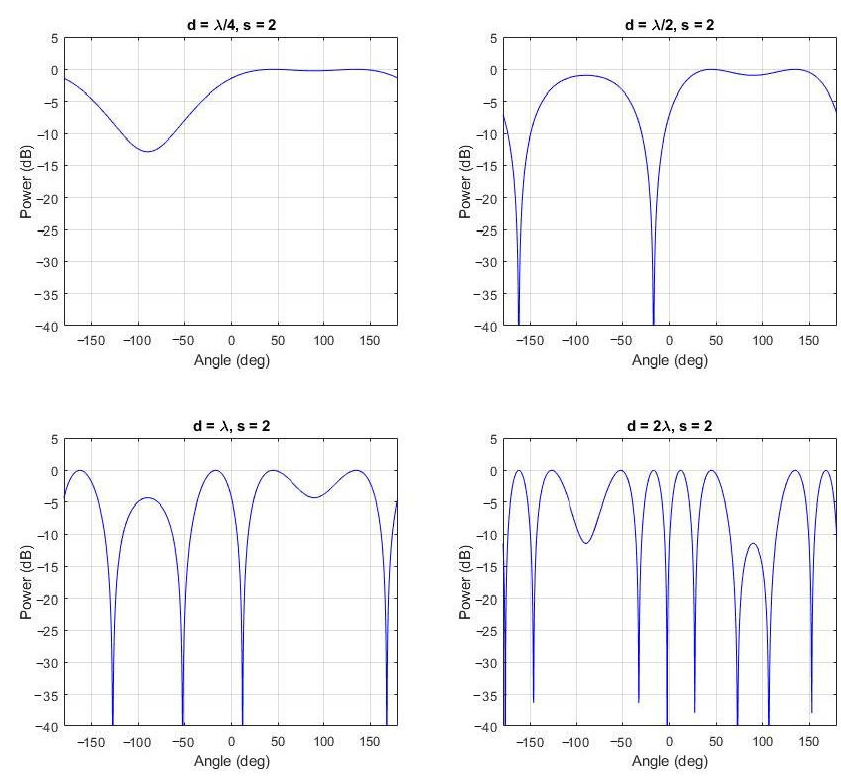
Figure 8. Beampattern analysis for incoming signal at 45 ◦ with 2 sensors.